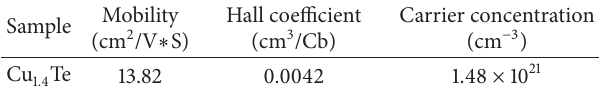
Te thin films. 1.4